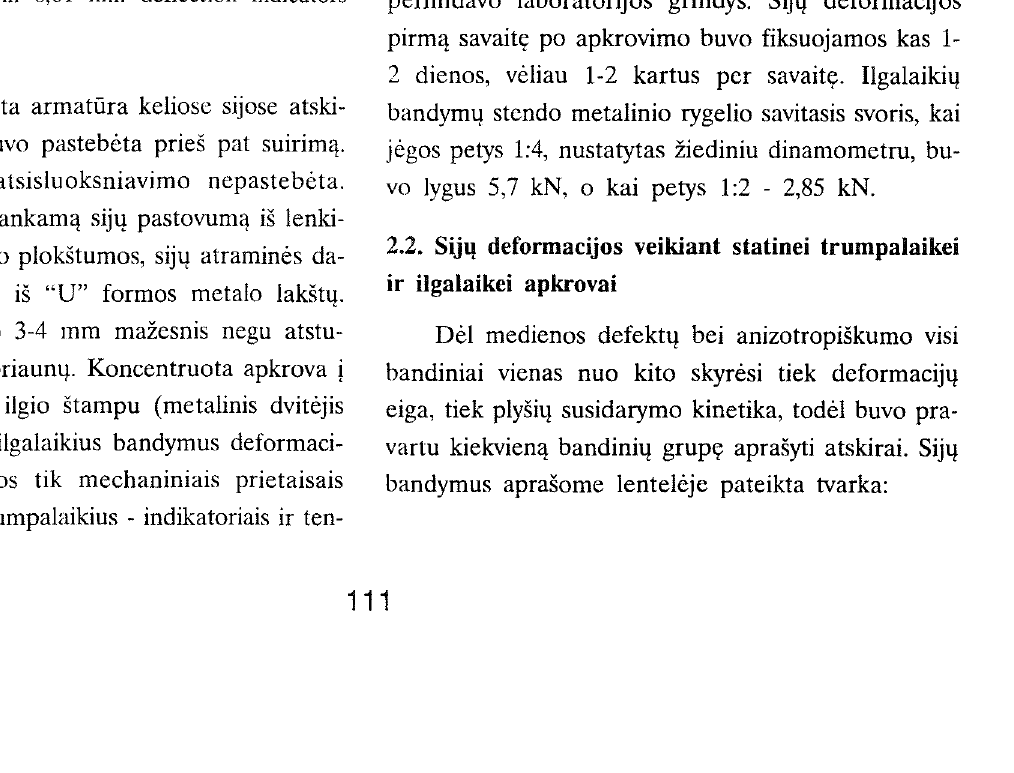
2 pav. Indikatoril! isdestymo schema sijq bandyml! metu: ,.-. - (0,001-0,002 mm) tikslumo indikatoriai (In. h-ln. 6) ant annati:iros, hazes ilgis - 10 em; Ci - 0,01 mm tiks lumo jlinkiamaciai OJ. 7 .;-p. 9) Fig 2. The scheme of indicators during a long-term test ing of beams: ,.-. - within precision of 0,001-0,002 mm indicators (In. 1 .;-In. 6) on reinforcement in the base of 10 em; Ci - to within 0,01 mm deflection indicators w. hJI. 9).